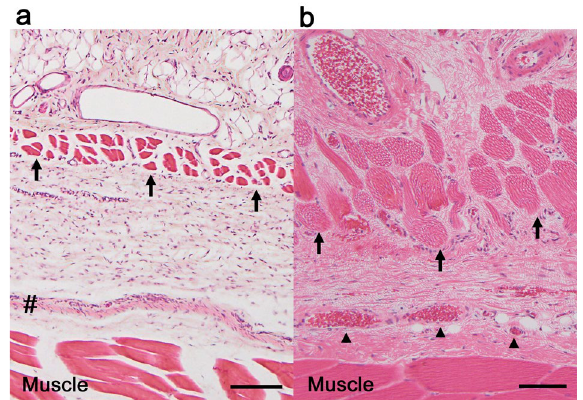
Figure 2. Micrographs of the sequential section of skin and rectus femoris muscle stained with hematoxylin– eosin (HE). ( a ) Conventional fixation. In general, the rat has a ‘panniculus muscle (arrow)’ 33 between the subcutaneous tissue and the deep fascia. Contraction of the panniculus and rectus muscles resulted in decreased volume, and a strongly contracted band (#) was observed in the deep fascia. Scale bar = 100 µm. ( b ) Plunge freezing and freeze-substitution. The panniculus muscle (arrow) and the rectus femoris muscle were thick and not contracted. The presence of blood vessels (arrowhead) within the deep fascia is clearly shown, and the strongly contracted band is not identified. The deep fascia is still not well-structured. Scale bar = 100 µm.